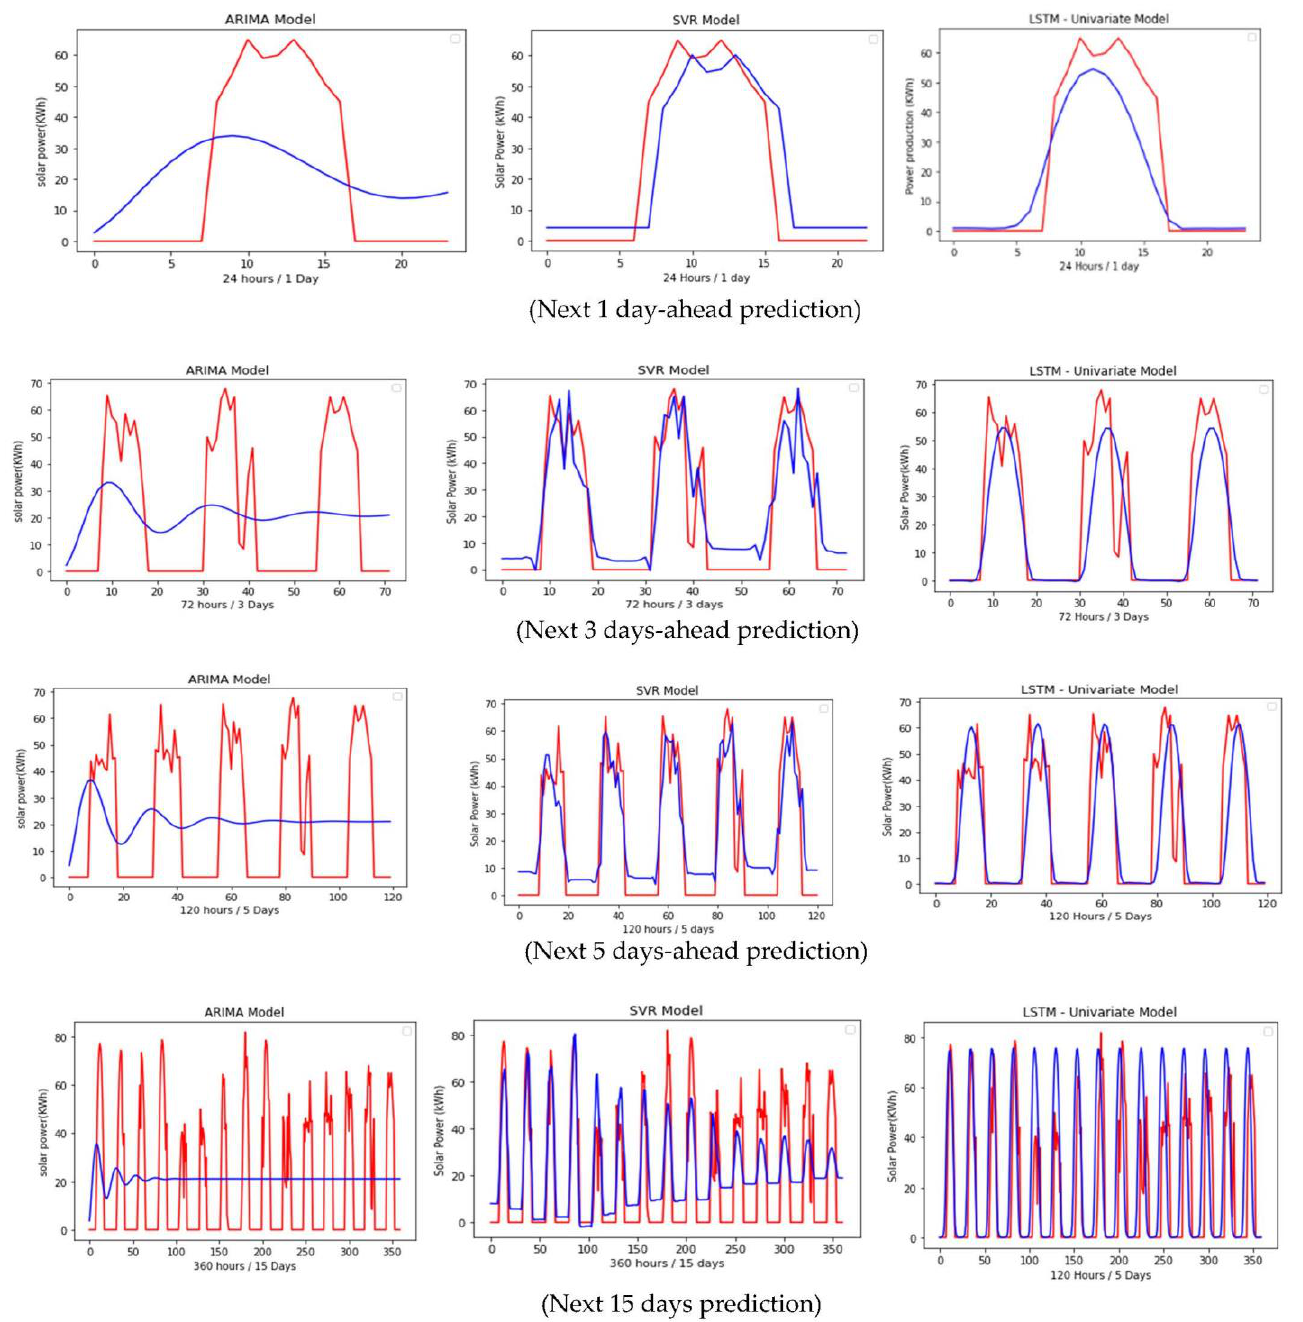
Figure 15. Comparison between the ARIMA, SVR, and LSTM model for solar power forecasting. Row 1, 2, 3 and 4 represents comparison between models for next 1-day, 3-days, 5-days and 15-days prediction respectively. Column 1, 2, 3 represents ARIMA, SVR and LSTM model respectively (red line = actual, blue line = Predicted).